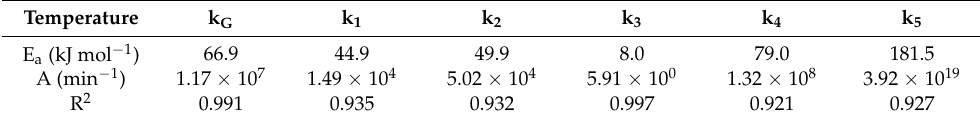
Table 3. Kinetic parameters for the conversion of glucose into furfural at different temperatures. Temperature k G k